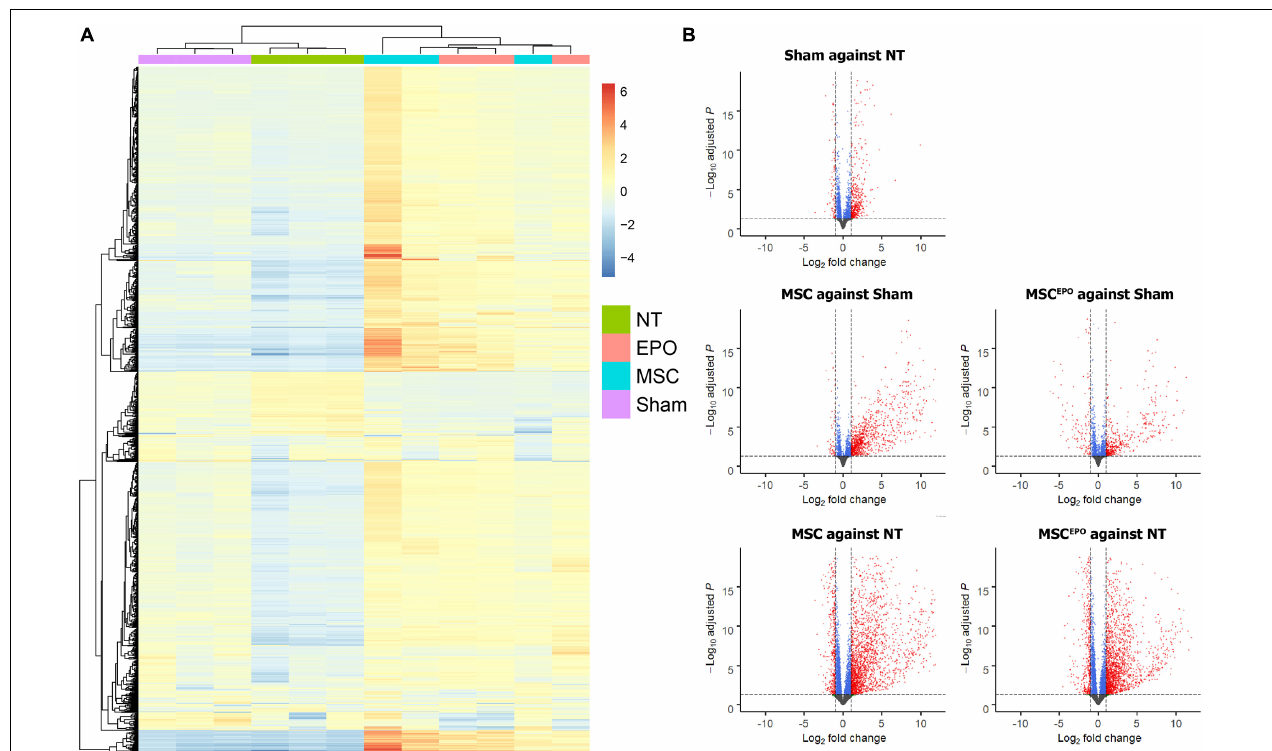
FIGURE 5 | Differential gene expression analysis of normalized count data. (A) A heatmap was constructed to show hierarchical clustering of the top 1000 genes with the highest variance across all biological replicates. (B) After differential gene expression analysis was carried out, volcano plots were constructed to visualize the DEGs. Genes that have passed the threshold were represented as red dots ( P adj < 0.05, fold change > ± 2.0). About 1000 DEGs were over and underexpressed in the sham group when compared with the healthy control. By using sham as the reference, 1559 overexpressed and 634 underexpressed DEGs were detected in the MSC group. The MSC EPO group had 1009 overexpressed and 847 underexpressed DEGs. By using NT as the reference, both MSC and MSC EPO groups were found to have more than 3000 DEGs that were over and underexpressed. NT, no-treatment/healthy control; Sham, NaIO 3 -only/vehicle control; MSC, MSC-transplanted group; MSC EPO , MSC EPO -transplanted